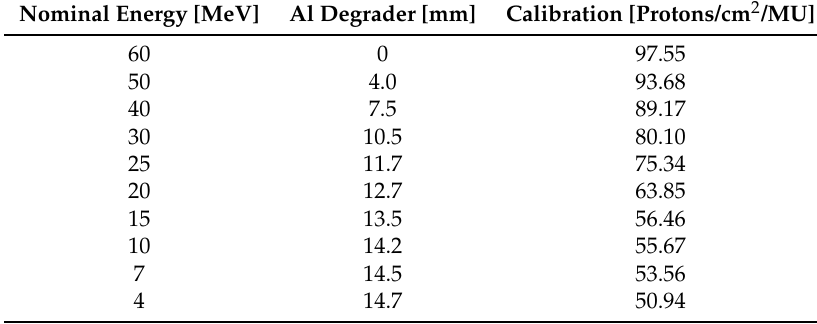
Table 2. Specification of the low energies at the DUT position (MeV) and resulting calibration factor (protons per cm 2 per MU) for the desired configuration and the amount of degrader material (mm Aluminum) that needed to be